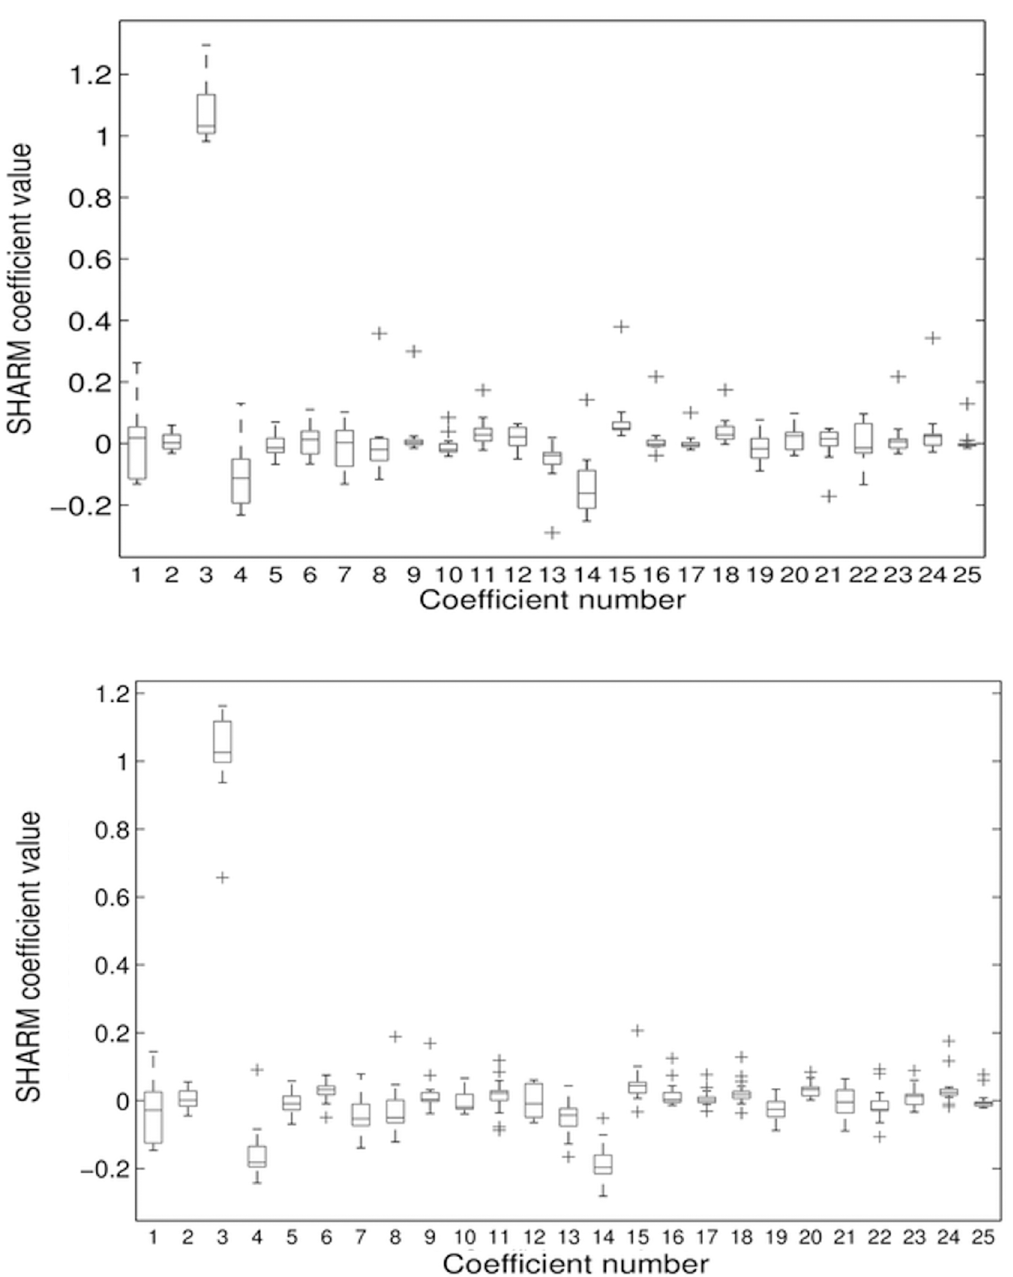
Fig 2. The statistics of SPHARM estimates (box-plots) of calcaneus (the first 25 coefficients) for the group of 18 left (top) and 18 right calcanei (bottom). Crosses indicate outliers.